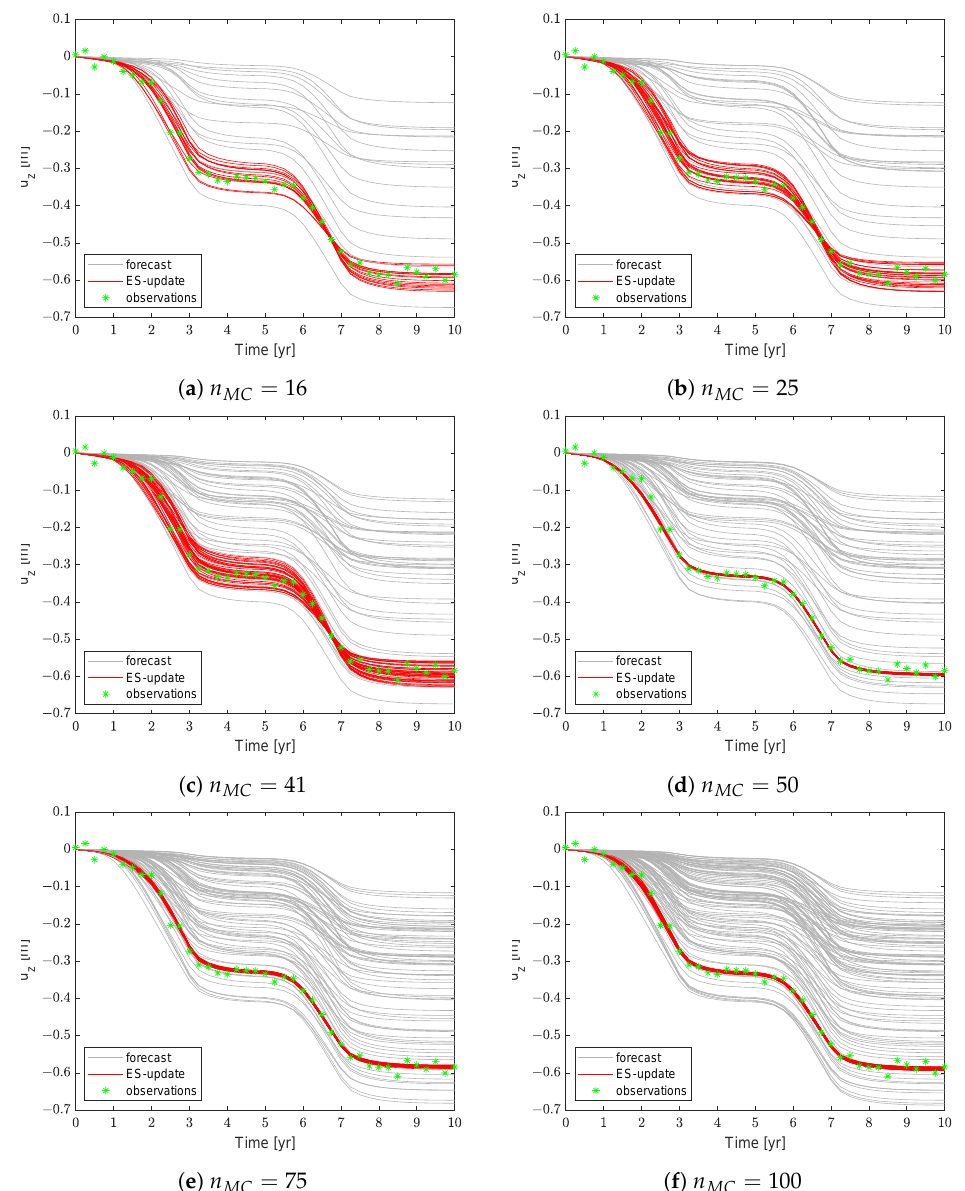
Figure 5. State ensembles for increasing number of Monte Carlo realizations n MC . In this case, the forecast ensemble (the grey one) has been obtained through the geomechanical model. The update ensemble (in red) is directly the output of the ES technique, that is, it does not derive from the geomechanical model run with the update ensembles of the